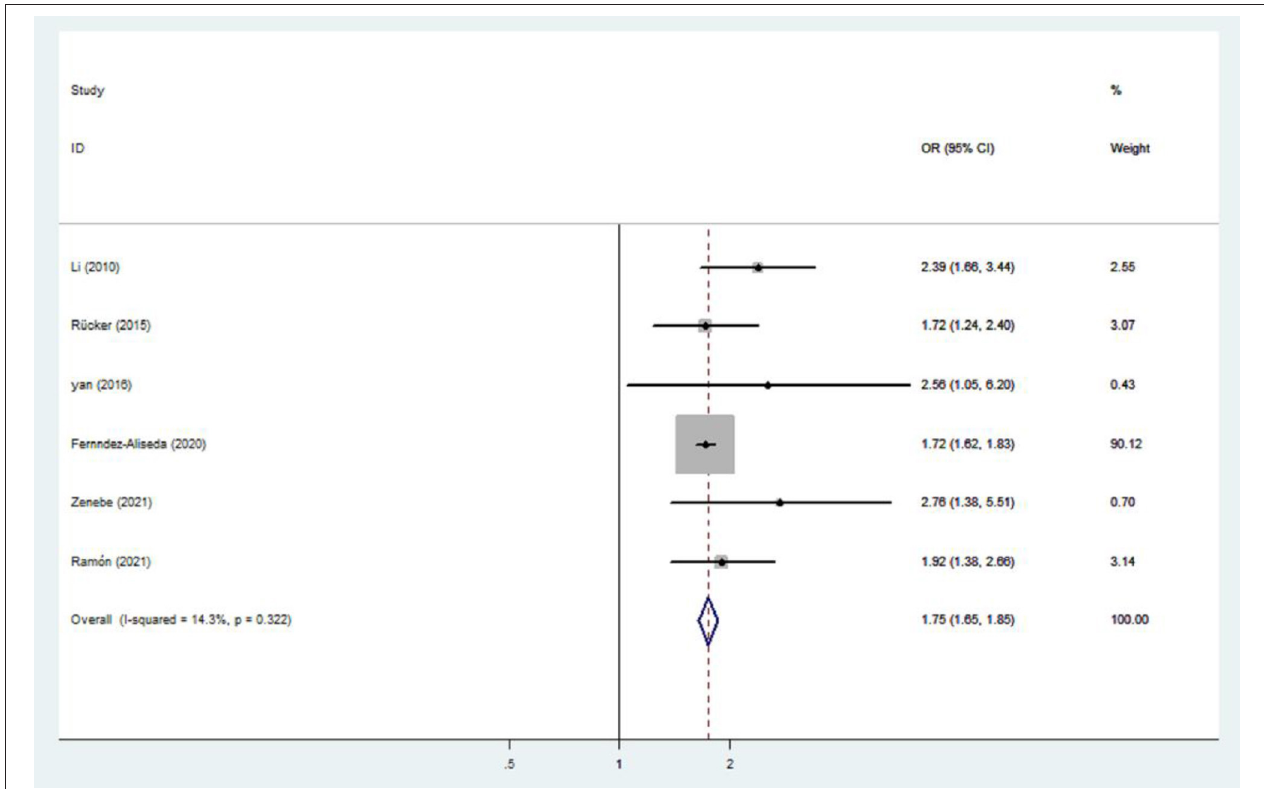
FIGURE 6 | Effect of IAD on drinking